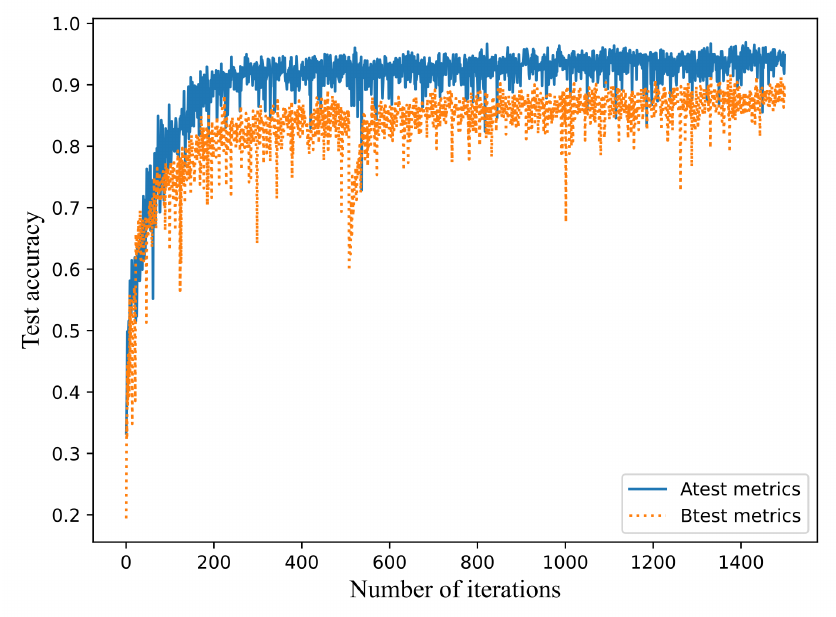
Figure 13. Training process of raw data and amplitude